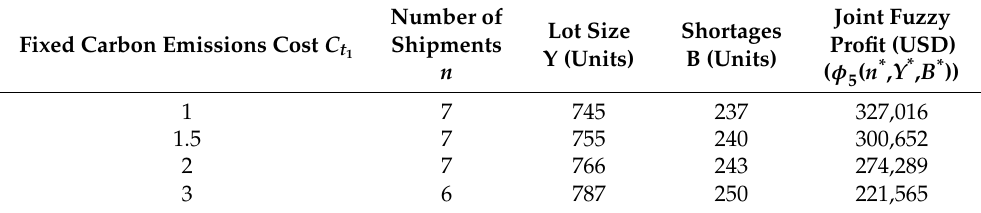
Table 15. Impact of the fixed carbon emission cost due to production on the decision variables and joint fuzzy profit.